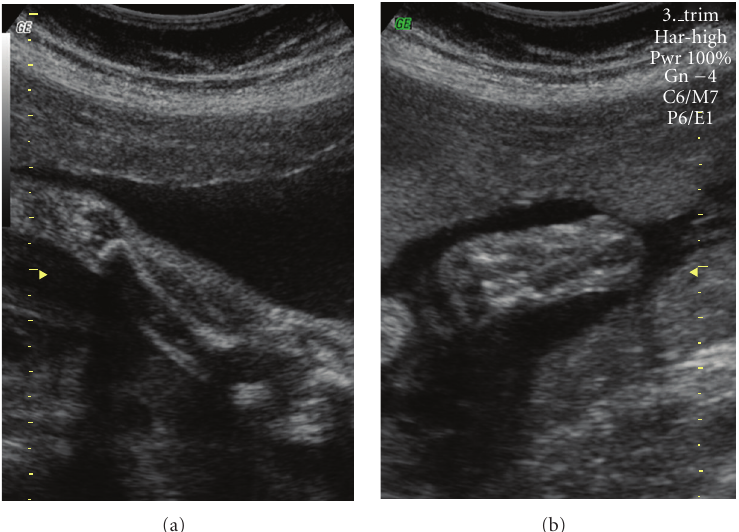
Figure 2: Ultrasound images showing absence of right fibula (a) and absence of the fourth and fifth right foot rays and digits (b) at 31 weeks